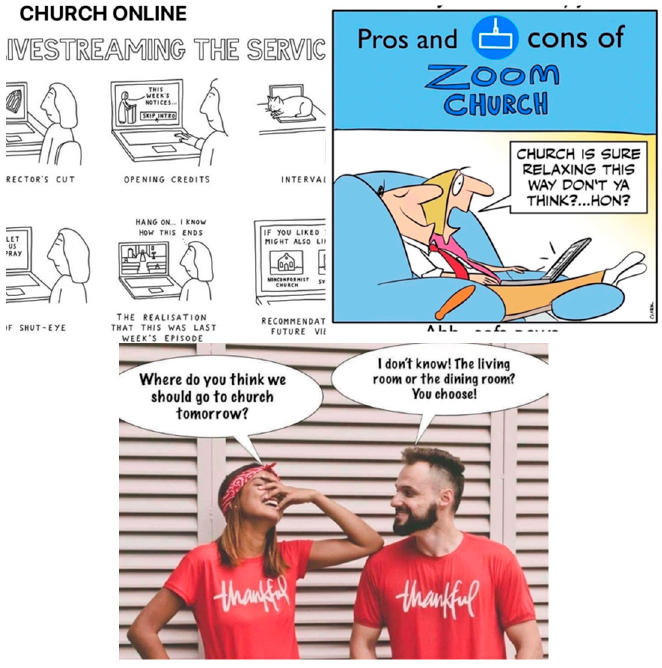
Figure 2. Examples of memes that suggest what church online is like during the pandemic, and people’s reactions to these experiences.